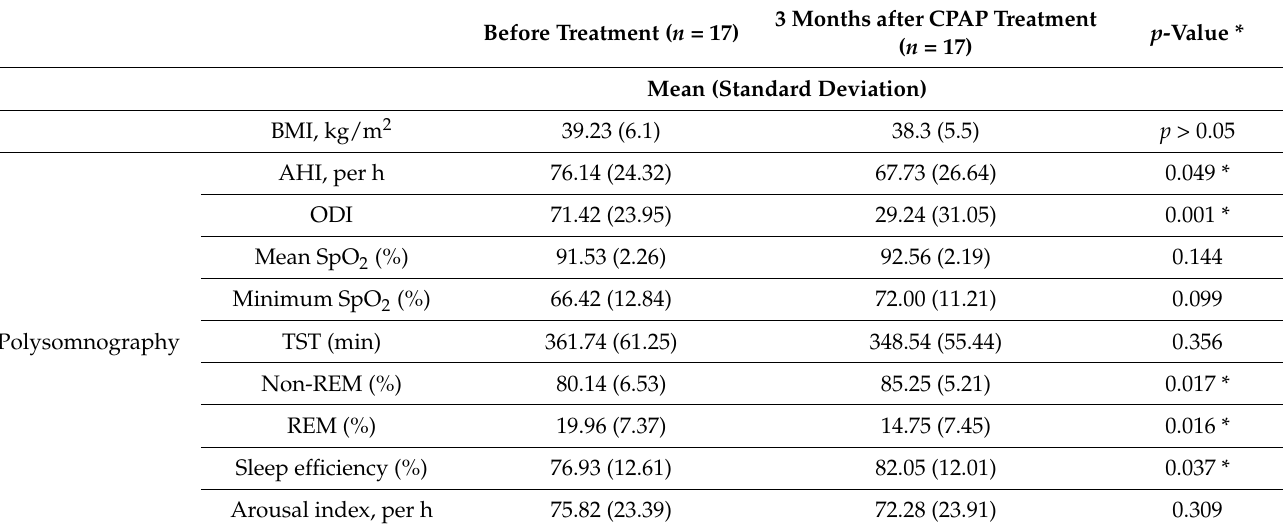
Table 1. Baseline characteristics before and after